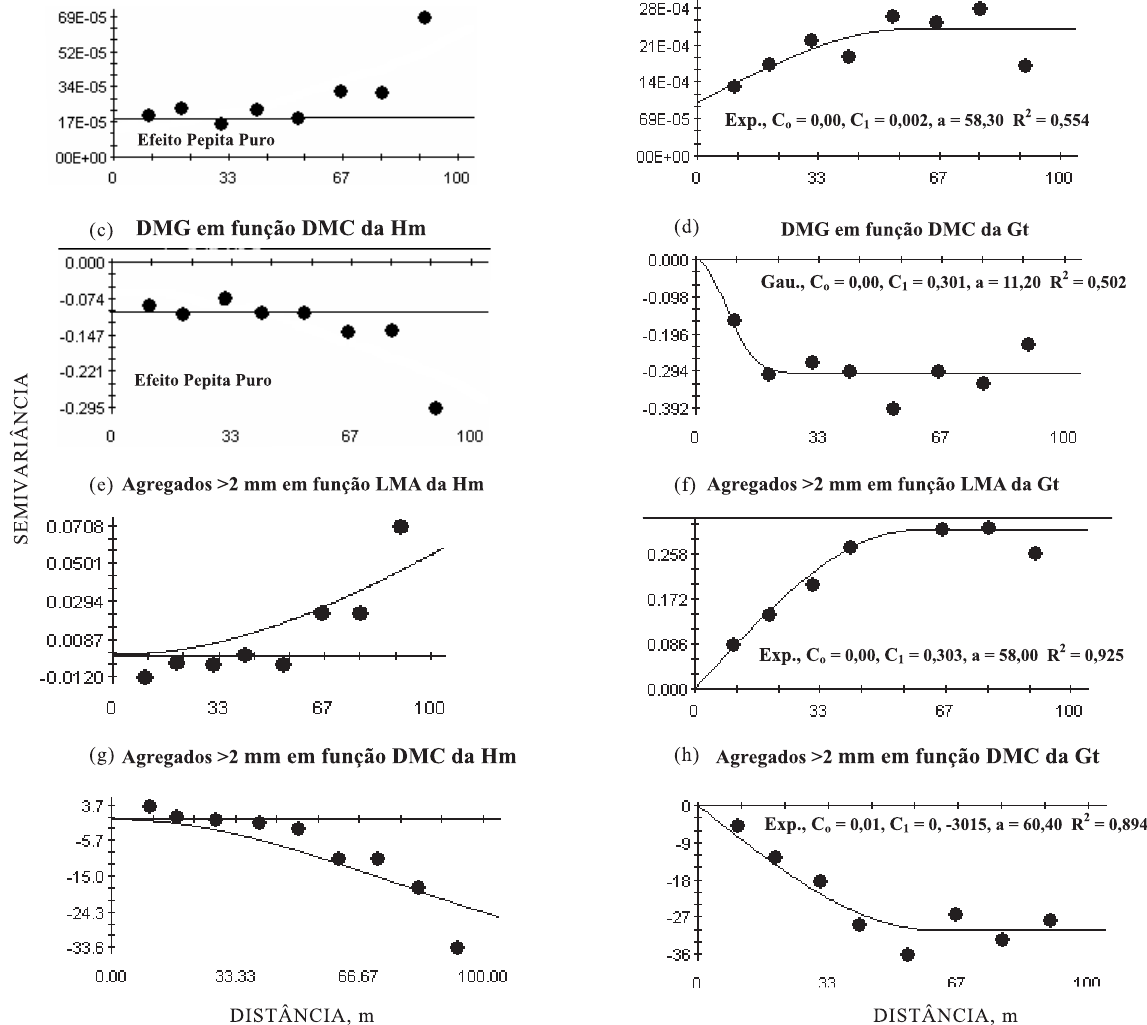
Figura 3. Semivariogramas cruzados dos atributos estudados. Gau.: gaussiano, Esf.: esférico; C